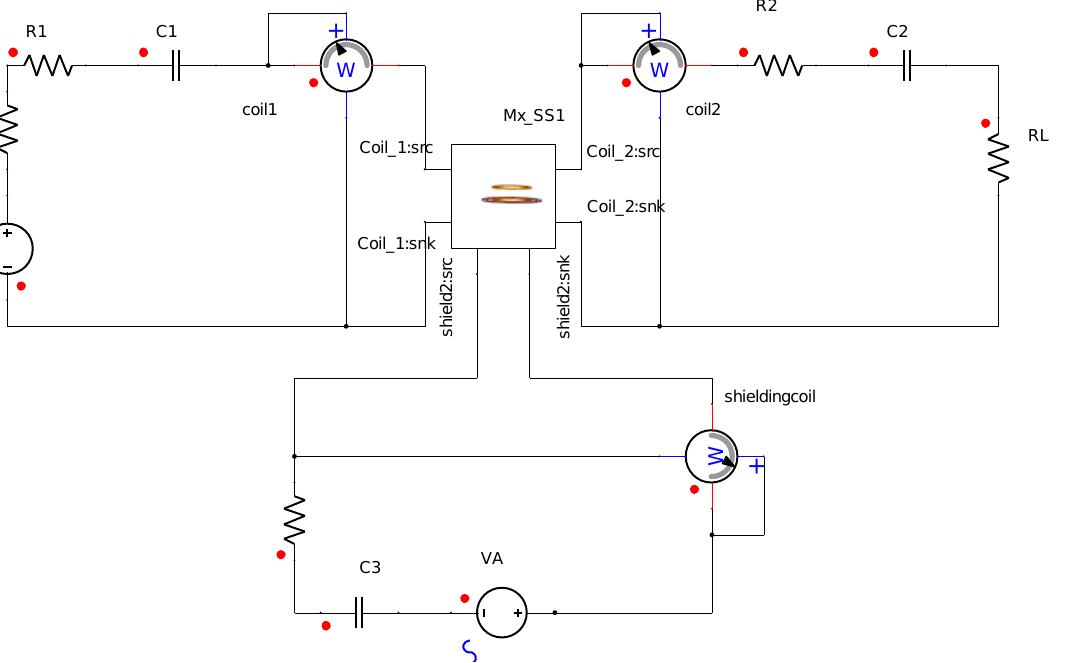
Figure 9. Circuit for the combined simulation by 3D Maxwell and Simplorer. Table 2. Simulation parameters of WPT circuit.